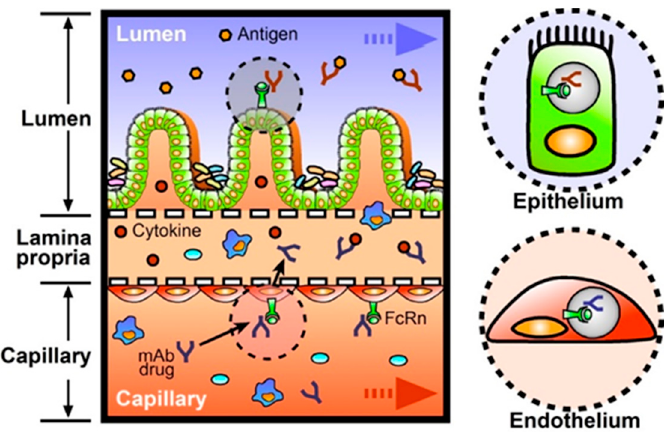
Figure 5. A schematic diagram of the transcytosis of monoclonal antibody (mAb) drugs across the lumen-mesenchyme-capillary tissue interface. Intravenously-administered mAb drugs (blue) bind to the neonatal Fc receptor (FcRn), in which the internalized endosome functions as a vehicle to carry this complex from the capillary layer into the lamina propria (a right bottom inset with a dotted circle). Released mAb drugs capture disposed proinflammatory cytokines (secreted by activated immune cells during IBD. Orally-delivered mAb drugs (red) can also be tested in this microphysiological system in situ (a right top inset with a dotted circle).